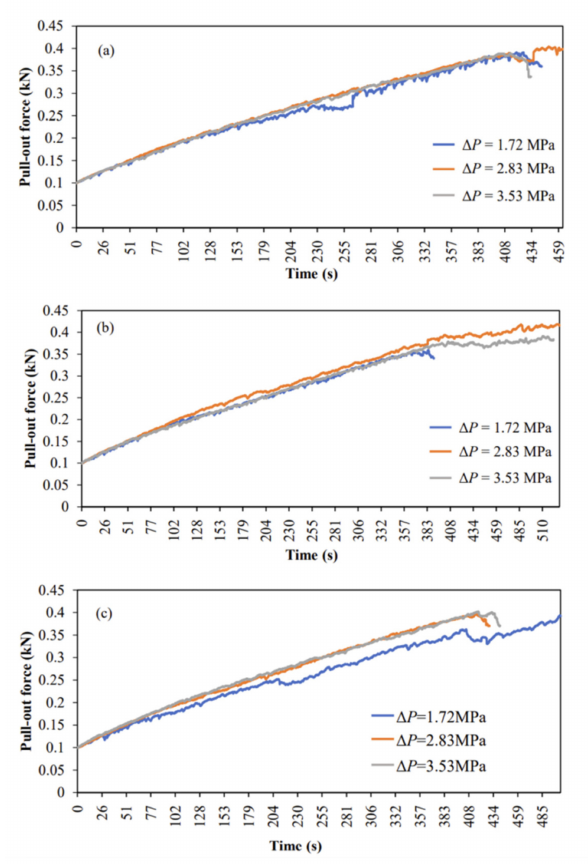
Figure 10. Variation in the pull-out force with the loading time at different hydraulic expansion pressures: ( a ) 16, ( b ) 17, and ( c ) 18